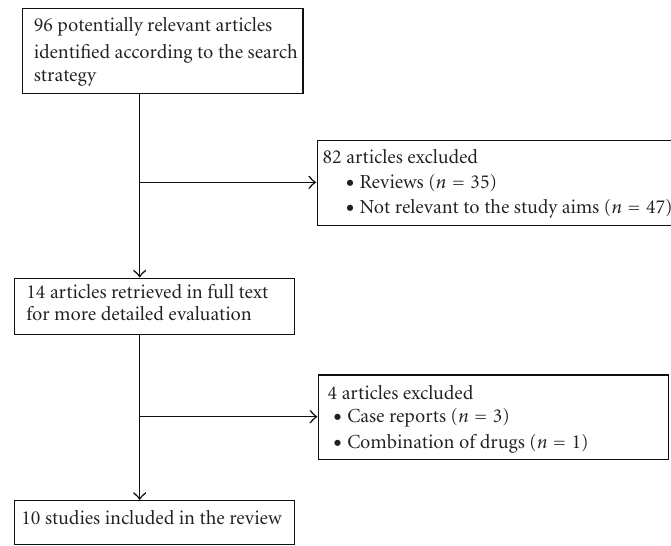
Figure 1: Flow Diagram of the